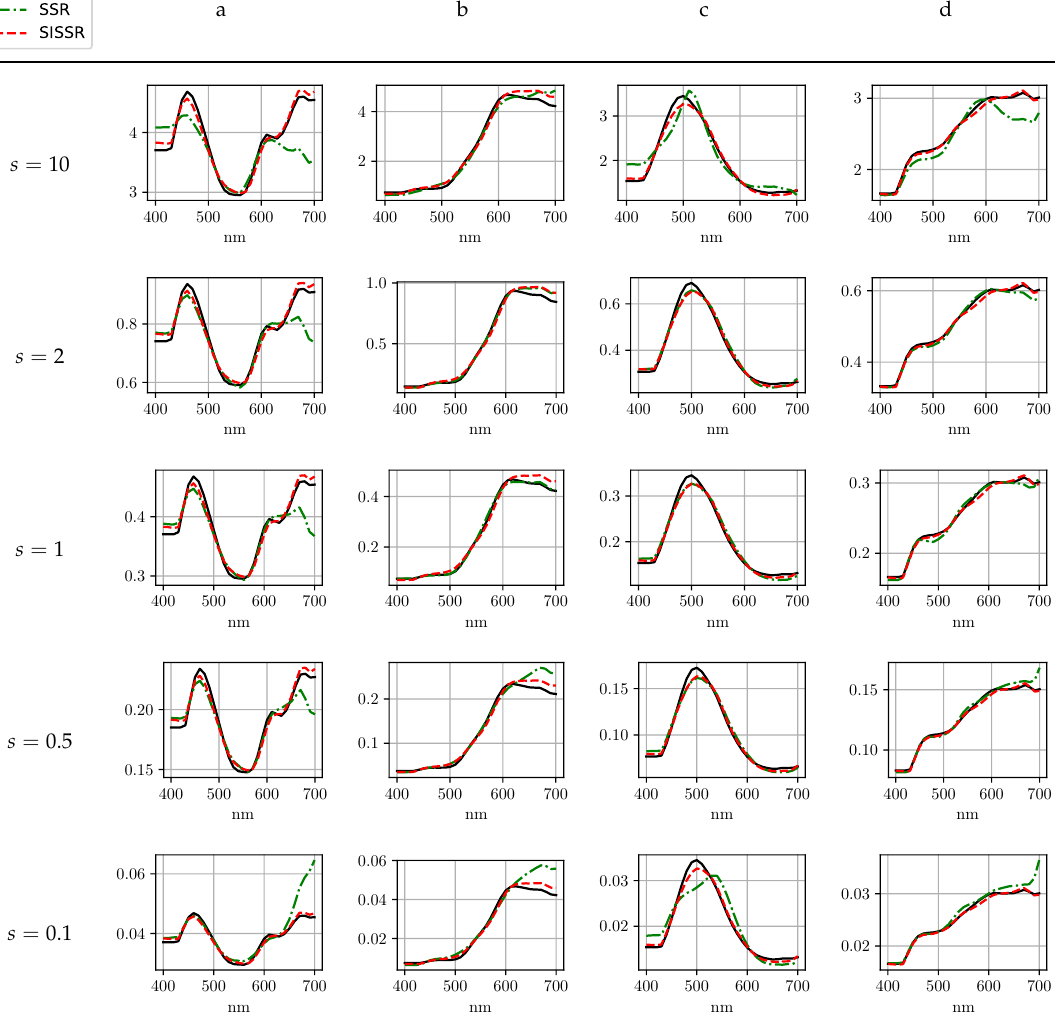
Figure 8. Exemplary reconstruction results for the adaptive weight attention network (AWAN) network [15] under varying scales. The pixel positions a–d are shown in Figure